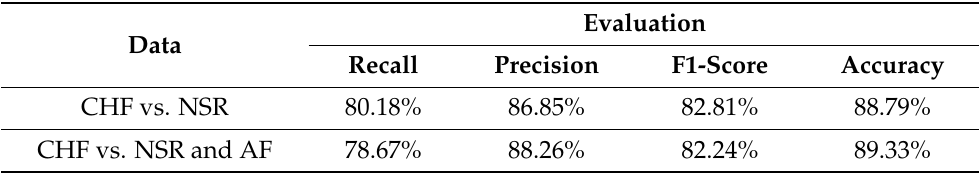
Table 5. The overall performance with different kinds of non-CHF signals when the segment length N =